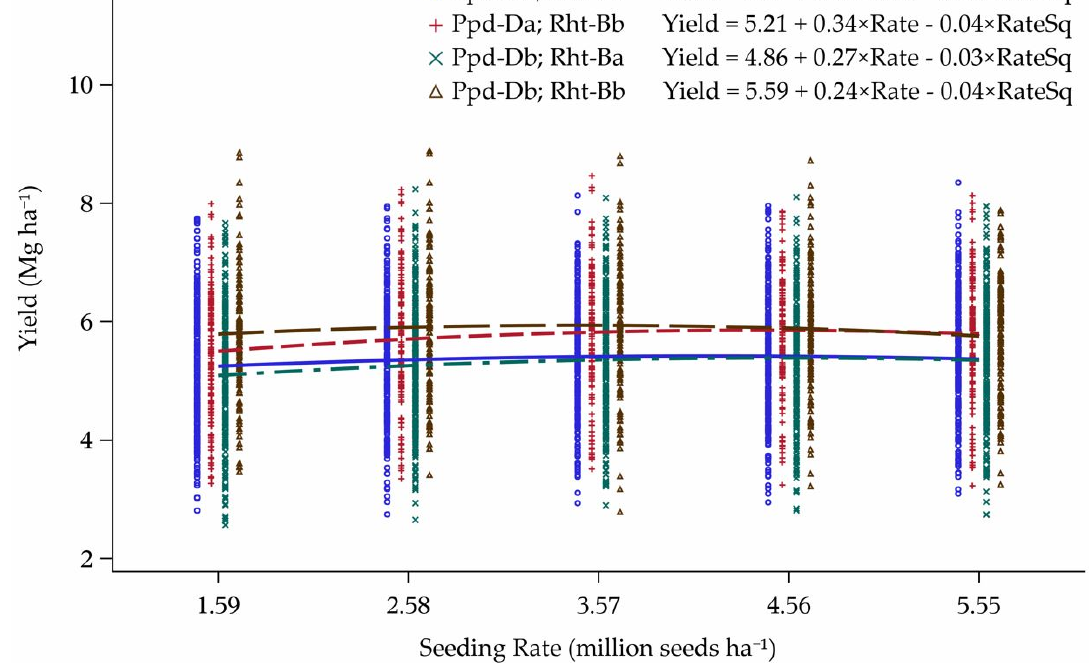
Figure 3. Yield response to seeding rate for the interaction between Rht-B and Ppd-D alleles over 21 environments in Minnesota and North Dakota, 2013–2015. Seeding rate at peak of curve: Ppd-Da ; Rht-Ba = 3.60, Ppd-Da ; Rht-Bb = 3.88, Ppd-Db ; Rht-Ba = 3.79, and Ppd-Db ; Rht-Bb = 2.94 million seeds ha − 1 .